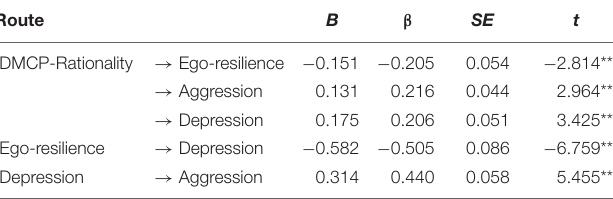
TABLE 4 | Path coefficients of the final model.